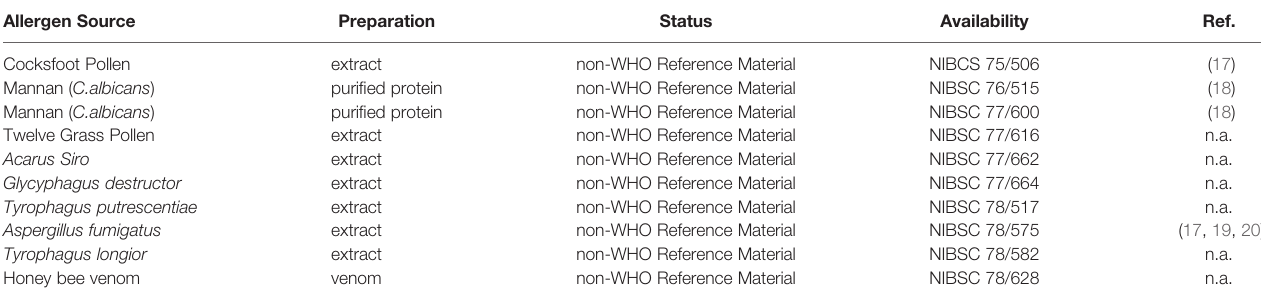
TABLE 1 | Non-WHO allergen reference materials established by NIBSC in the